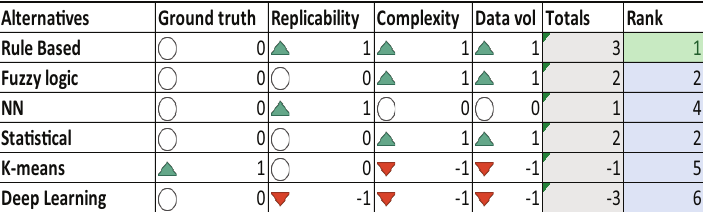
Figure 8. Decision matrix—Heart